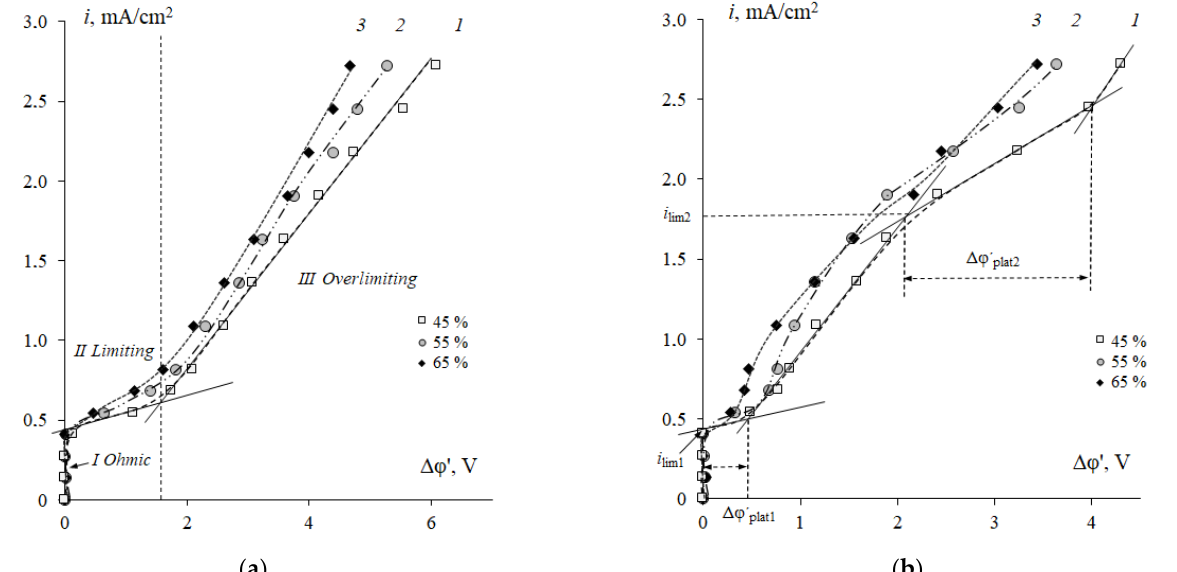
Figure 6. CVCs of cation-exchange membranes with the resin content of 45 ( 1 ), 55 ( 2 ) and 65 ( 3 ) wt% in 0.01 M NaCl solution ( a ) and in the mixed 0.01 M NaCl + 0.05 M Phe solution ( b ). Δφ ´ — corrected potential drop.